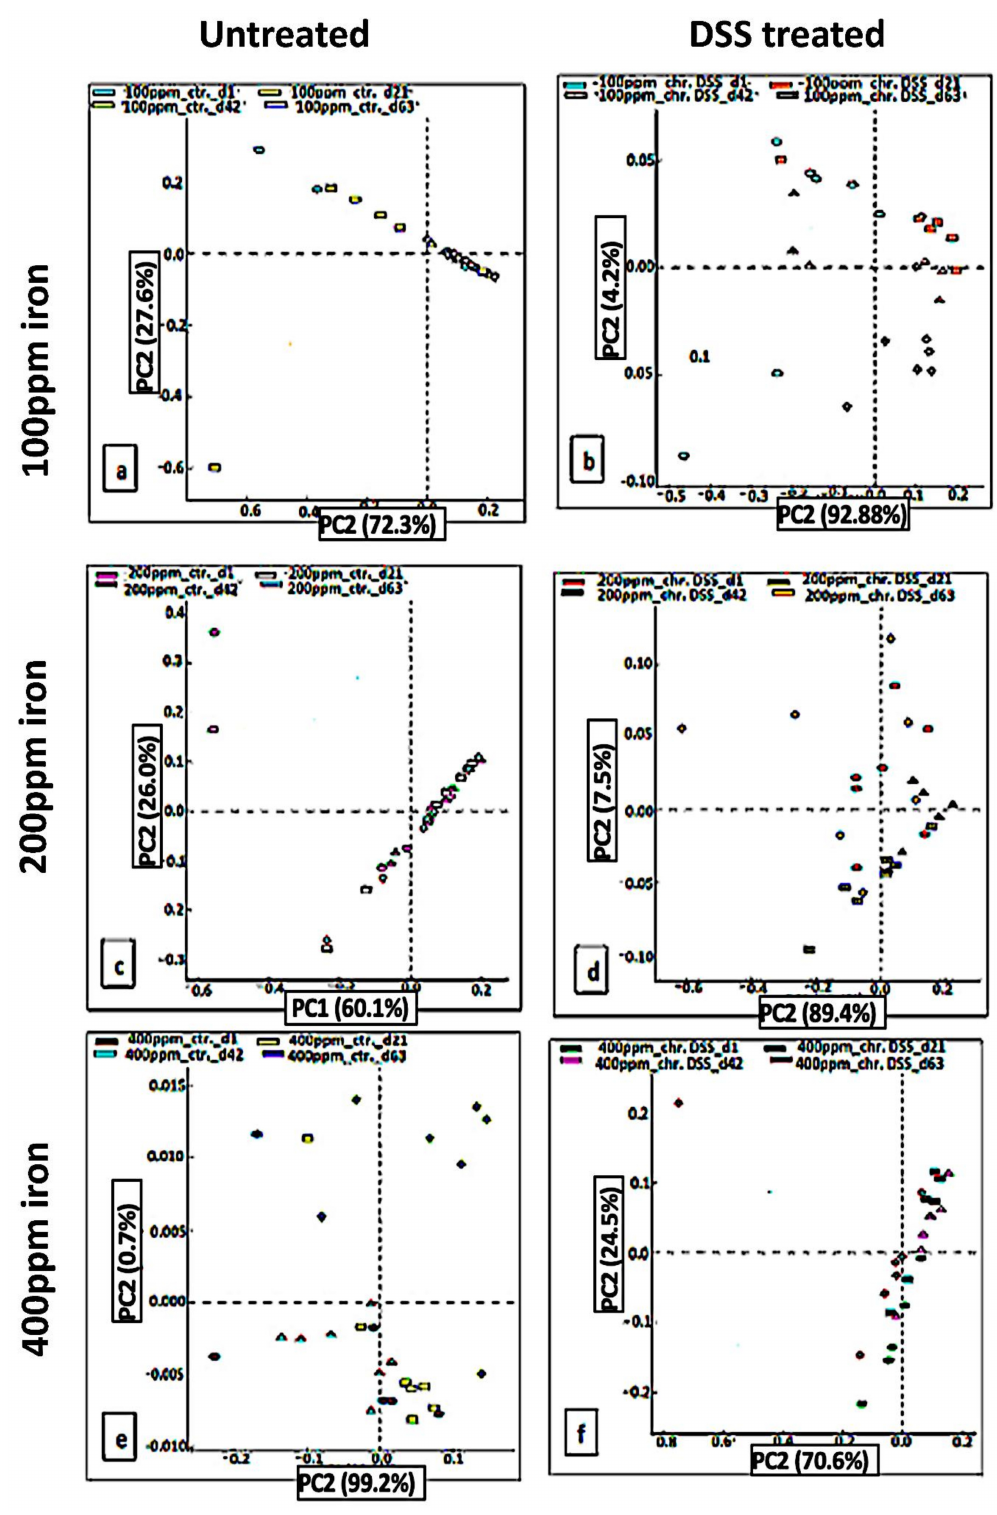
Figure 4. PCA to show unweighted UniFrac diseases after DSS treatment. In chronic DSS, PCA plots of the unweighted UniFrac distances of pre-and post-DSS-intervention stool samples from chronic (3 cycles) DSS – treated mice ( b , d , f ) and ( a , c , e ) untreated mice at phylum-level, phylogenetic classification of 16S rRNA gene sequences. Symbols represent data from individual mice, color-coded by the indicated metadata. Statistical differences were assessed by Kruskal–Wallis H-test followed by Storey’s FDR multiple test